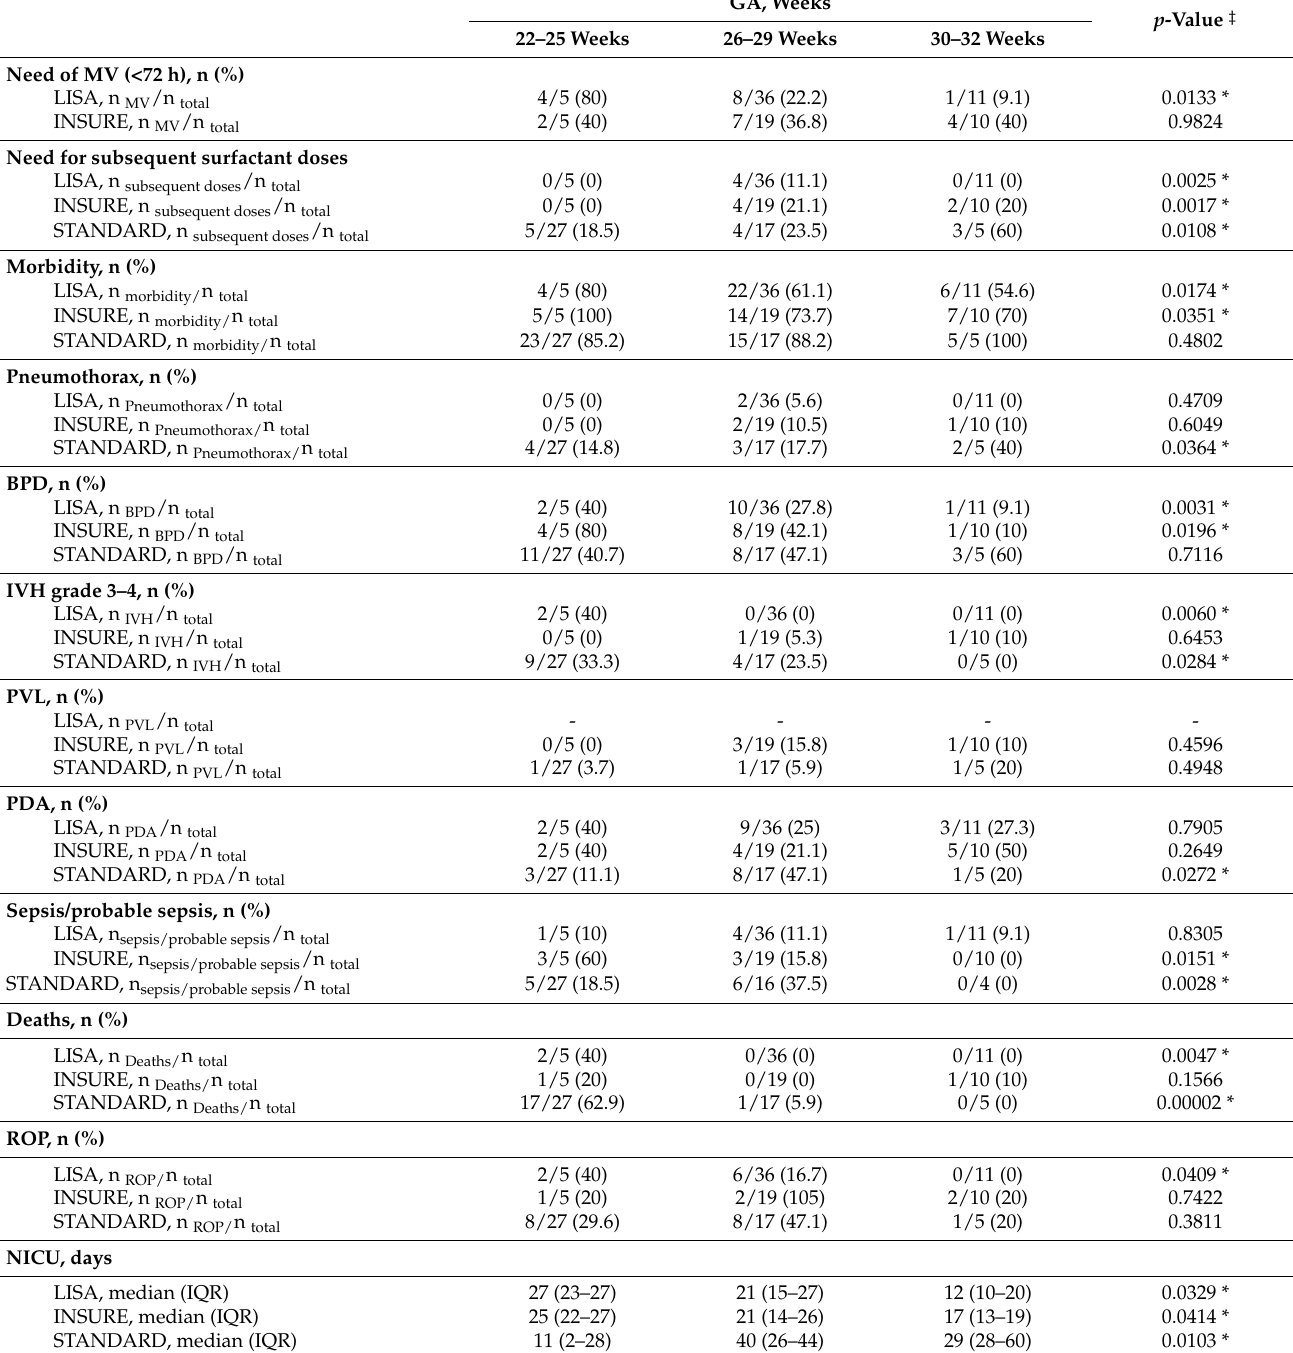
Table 4. Association of surfactant administration methods and gestational age with the subsequent need for mechanical ventilation and the occurrence of major neonatal